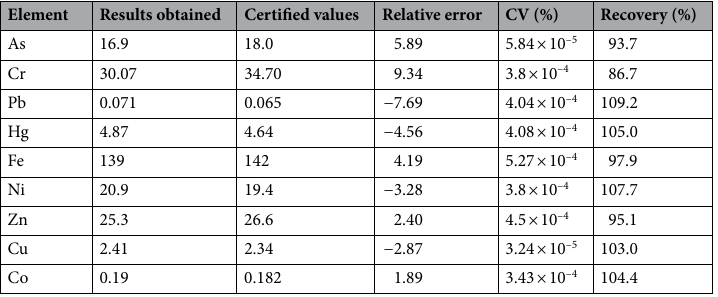
Table 1. Comparison between experimental results and certified values (mg kg −1 , dry weight, DORM-2).